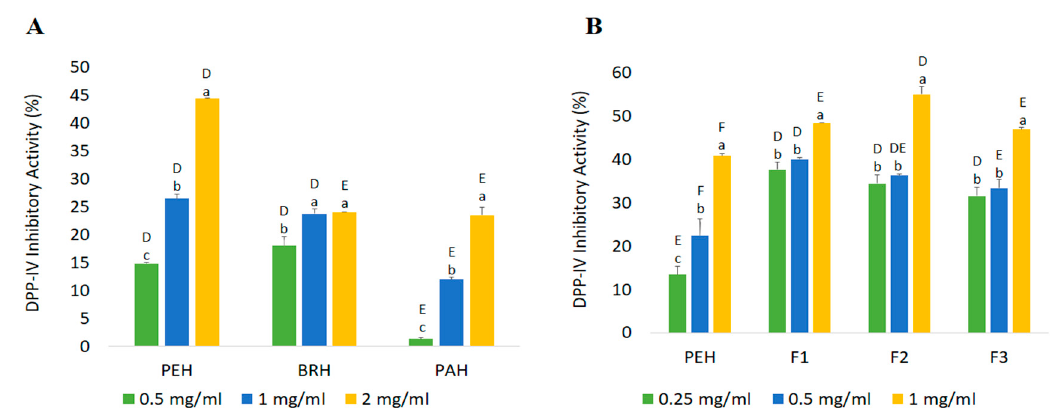
Figure 6. In vitro DPP-IV inhibitory activity of C angulata protein hydrolysates ( A ) and PEH fractions ( B ). Capital letters represent the significant difference ( p < 0.05) among samples at specific concentrations; and small letters among concentrations within each sample. Each value (in percentage) represents the average of three samples ± standard deviation ( n = 3).